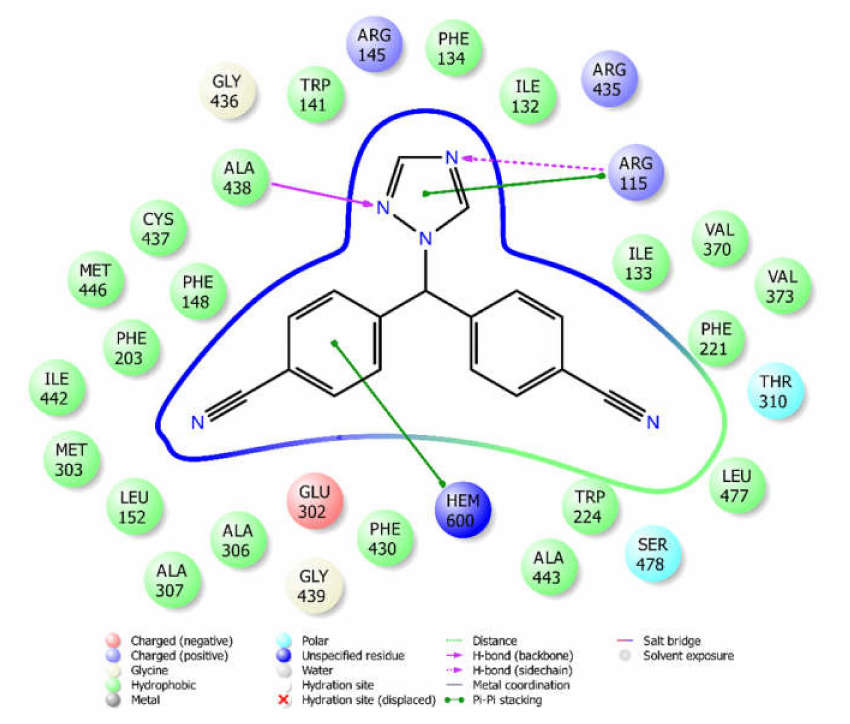
Figure 3. Two-dimensional interaction mode of letrozole in the enzyme active site (Human aromatase PDB Code: